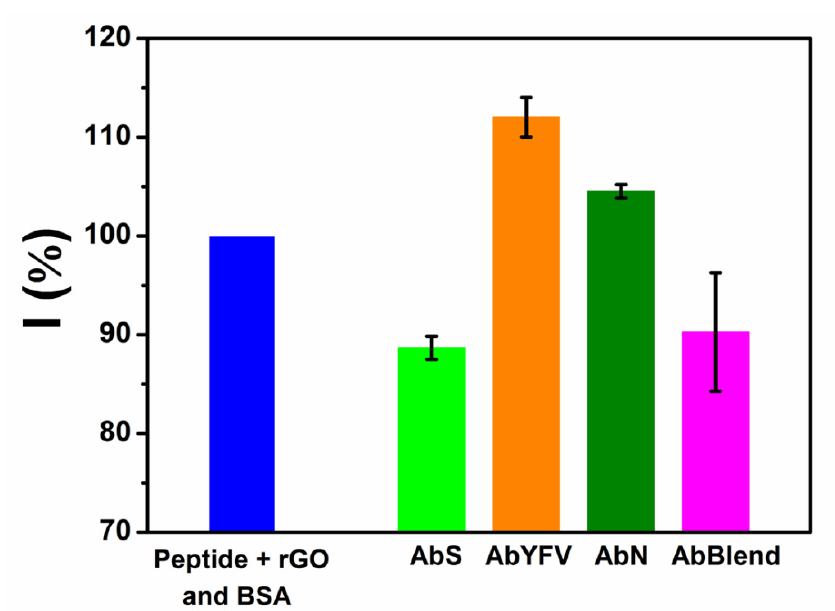
Figure 5. DPV data summarized for selectivity test against YFV antibodies, AbN SARS-CoV-2 and a mixture with AbS, YFV and AbN ( n = 3, ± SD).